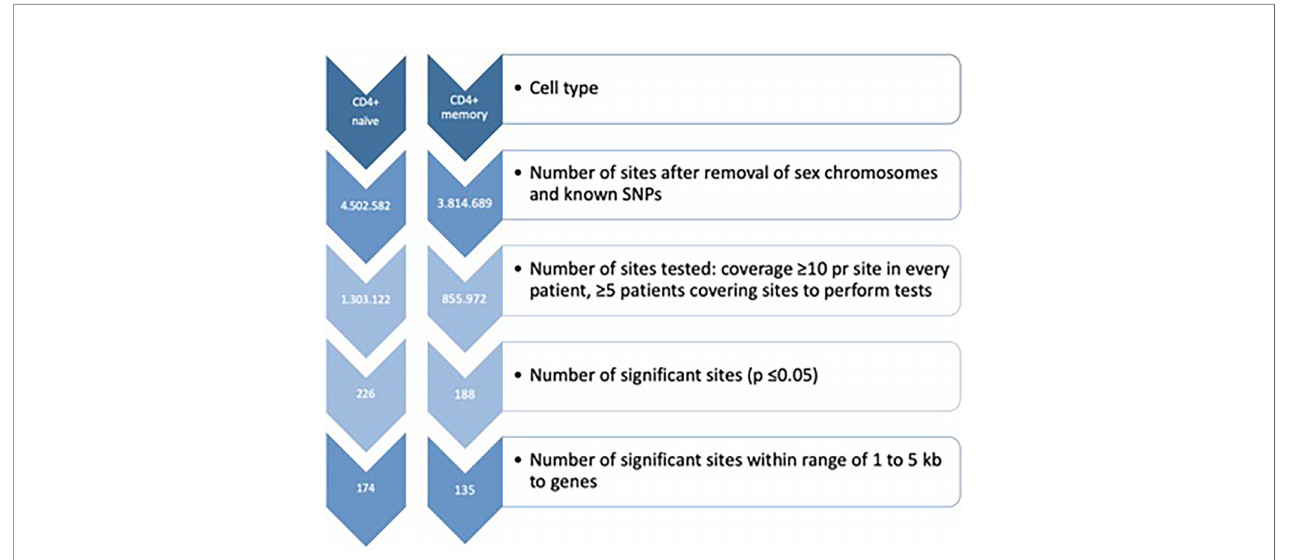
FIGURE 1 | Filtration criteria for identi fi cation of differentially DNA methylated CpG sites in both CD4 + naïve and memory T cells. SNPs, Single nucleotide